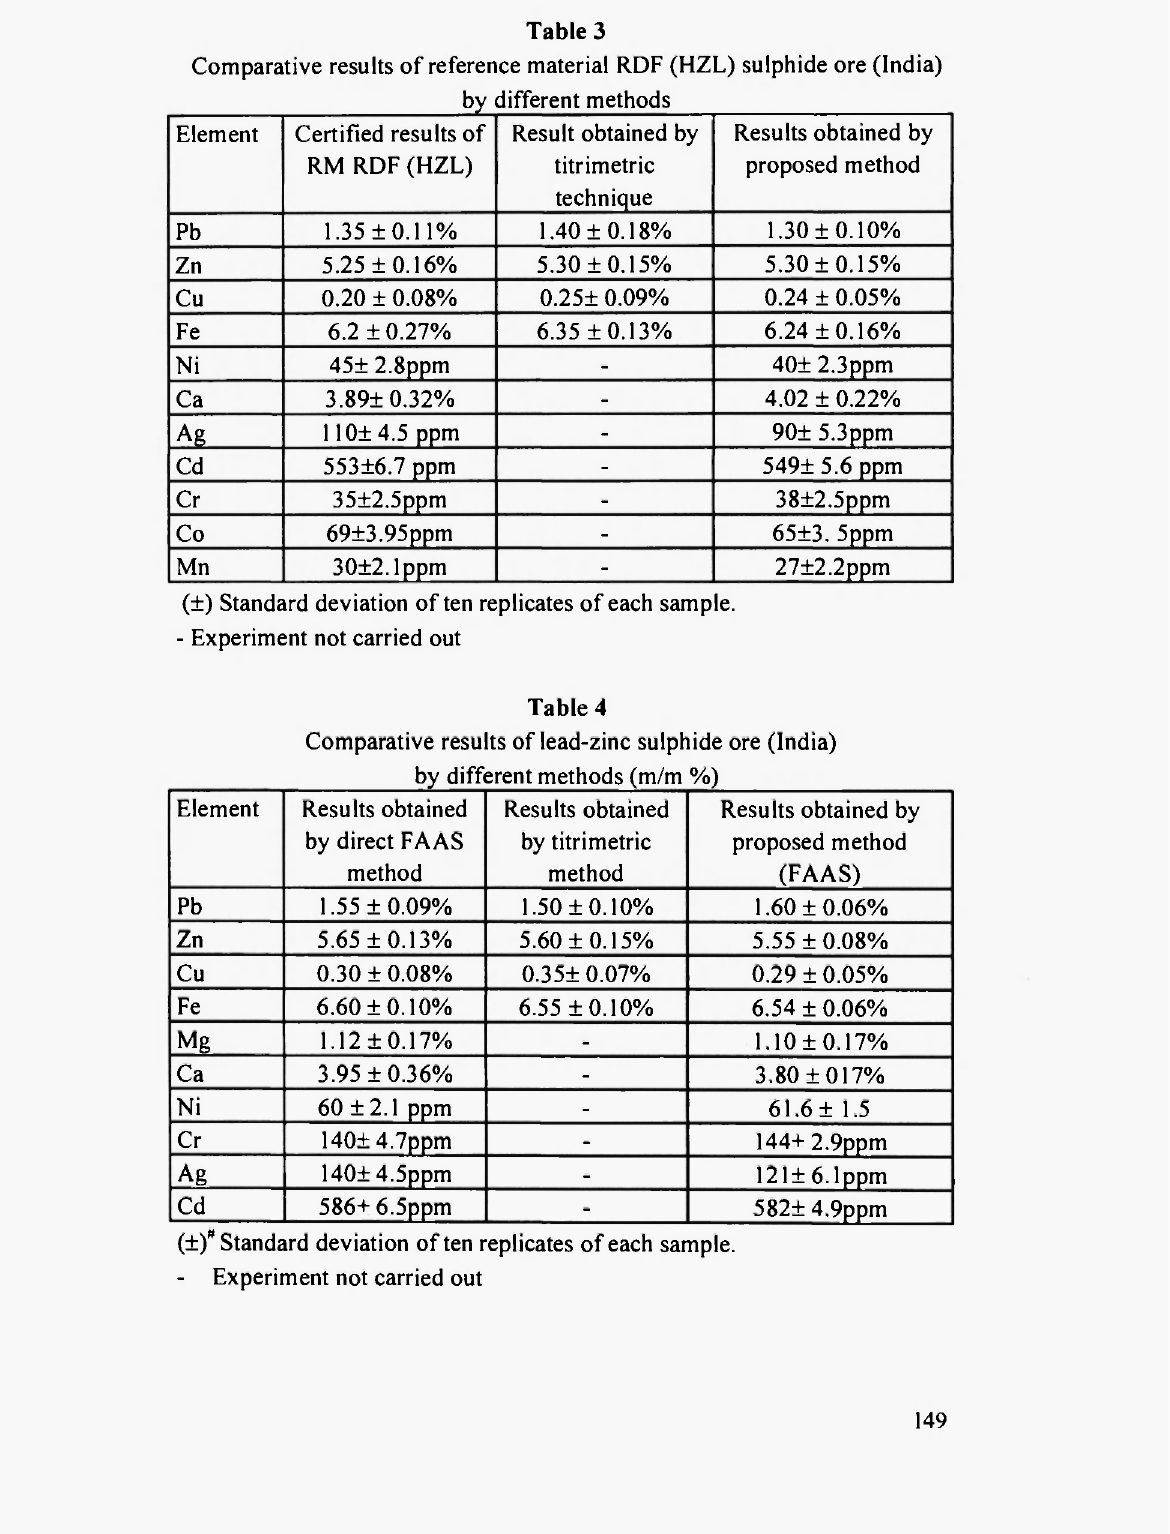
Comparative results of reference material RDF (HZL) sulphide ore (India) by different methods